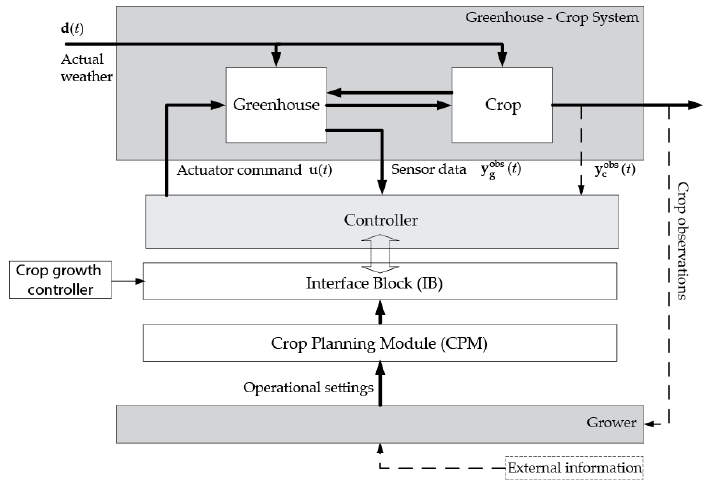
Figure 3. Crop planning module (CPM) and an interfacing block (IB) (adapted from [32]).